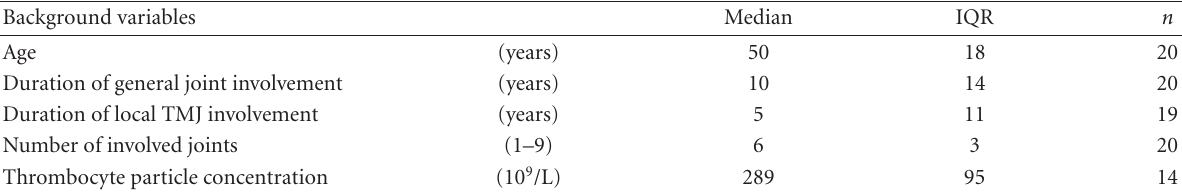
Table 1. Pretreatment data of 20 patients with chronic inflammatory joint disease subjected to intra-articular glucocorticoid injec- tions. IQR = 25th–75th percentile; n is the number of patients. Background